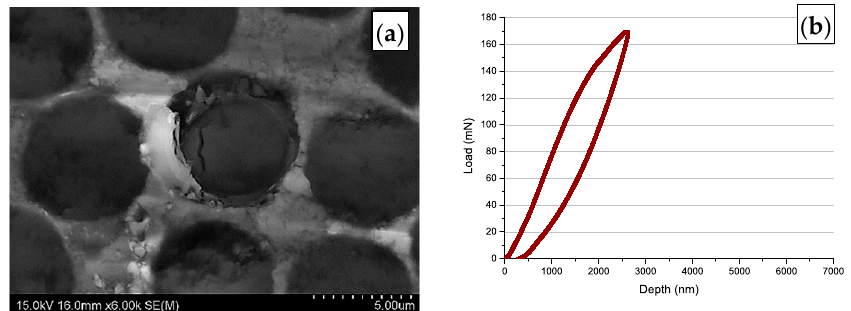
Figure 9. Typical curve obtained during push out tests with MMC4 sample ( a ), top surface SEM images of the MMC4 sample after push-out tests ( b ).